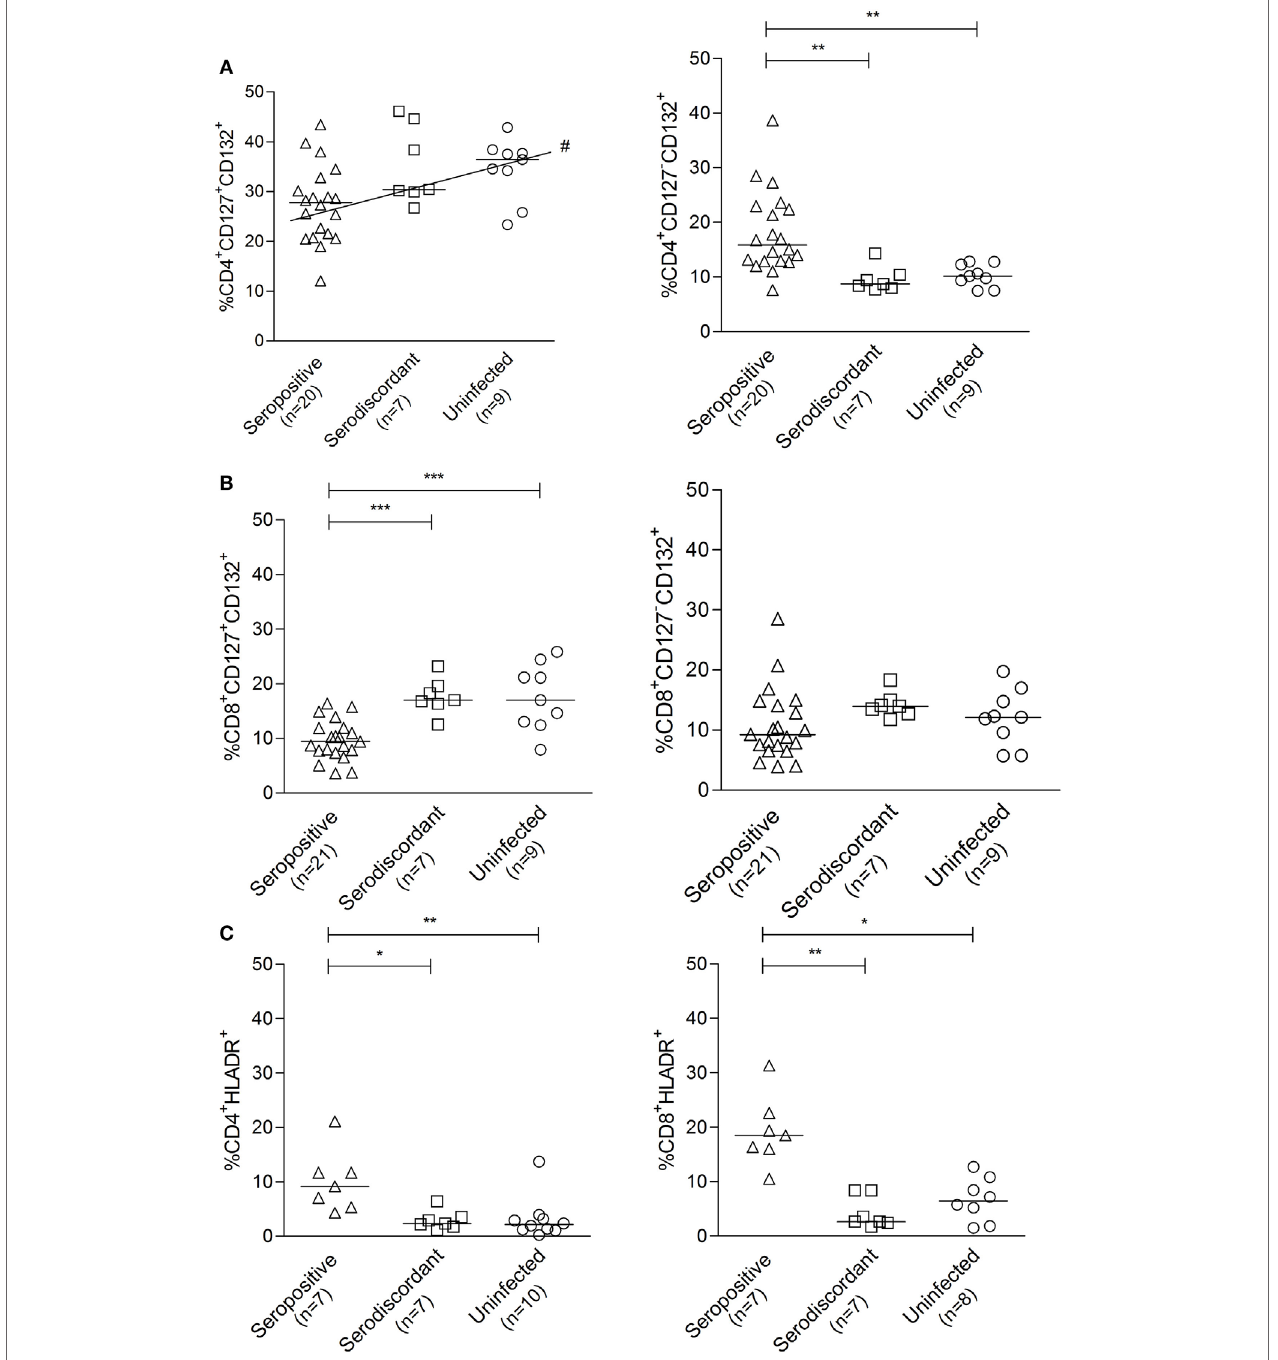
FigUre 5 | Cell surface expression of the interleukin (IL)-7 receptor components and HLA-DR in subjects with serodiscordant serology for Trypanosoma cruzi infection. Peripheral blood mononuclear cells (PBMC) were stained for CD8, CD4, CD127, CD132, and HLA-DR and analyzed by flow cytometry. Lymphocytes were gated by forward and side scattering. Each point represents the expression of CD127 and CD132 (a,B) or HLA-DR (c) on total CD4 + and CD8 + T cells for individual subjects. Median values are indicated by the horizontal lines. * P < 0.05; ** P < 0.001; *** P < 0.0001, # positive trend P < 0.05 for CD4 + CD127 + CD132 + T cells. Differences among groups were evaluated by ANOVA or Kruskal–Wallis test followed by